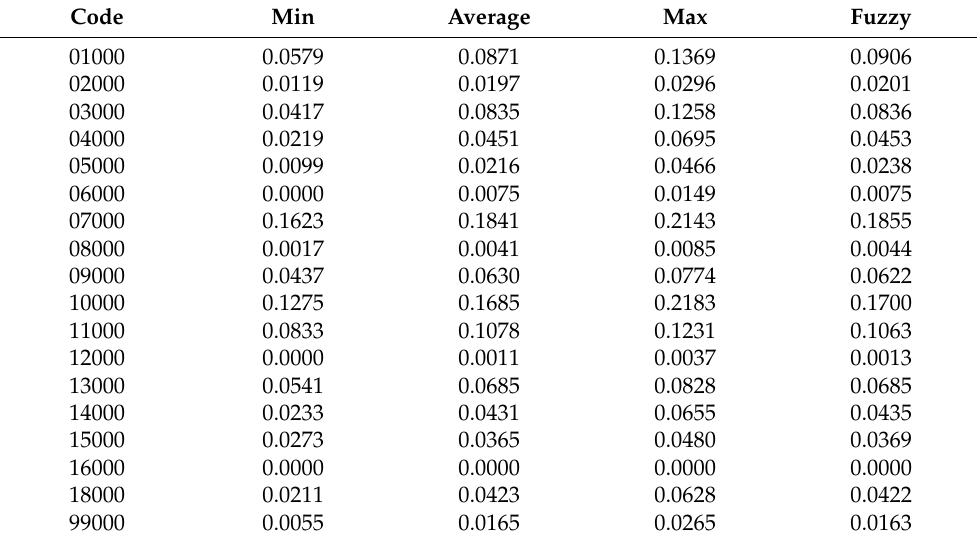
Table A6. The second step of fuzzification of Taiwanese ships deficiency data in Tokyo